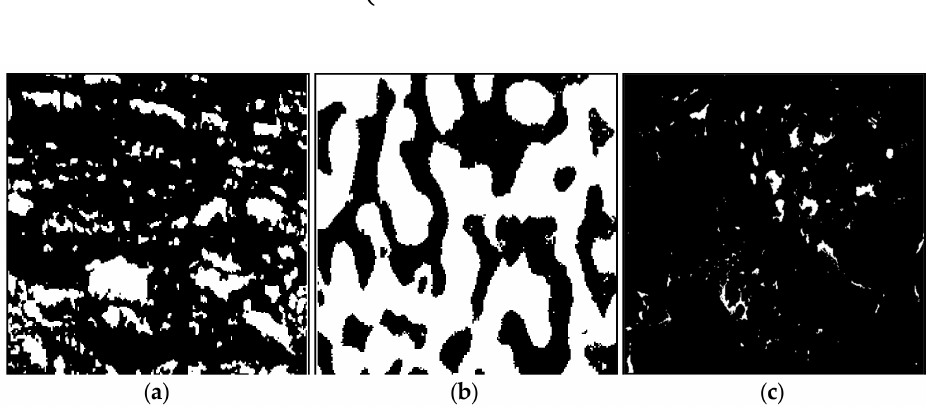
Figure 6. Image of coral reef after multi-scale pore structure recognition. ( a ) Macroscale image; ( b ) Mesoscale image; ( c ) Microscale